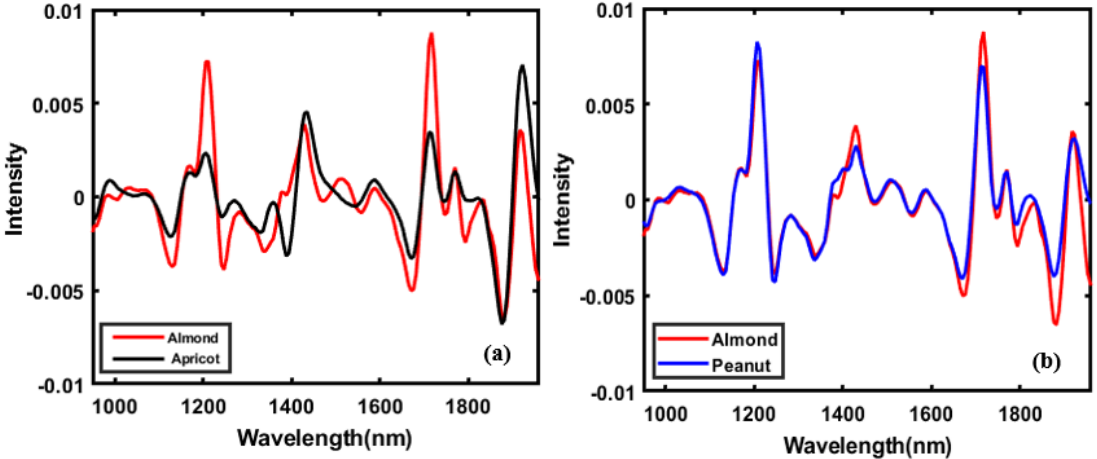
Figure 4. Mean spectra of almond powder and adulterants pre-processed using SG-second derivatives: ( a ) Almond and apricot, and ( b ) almond and peanut.